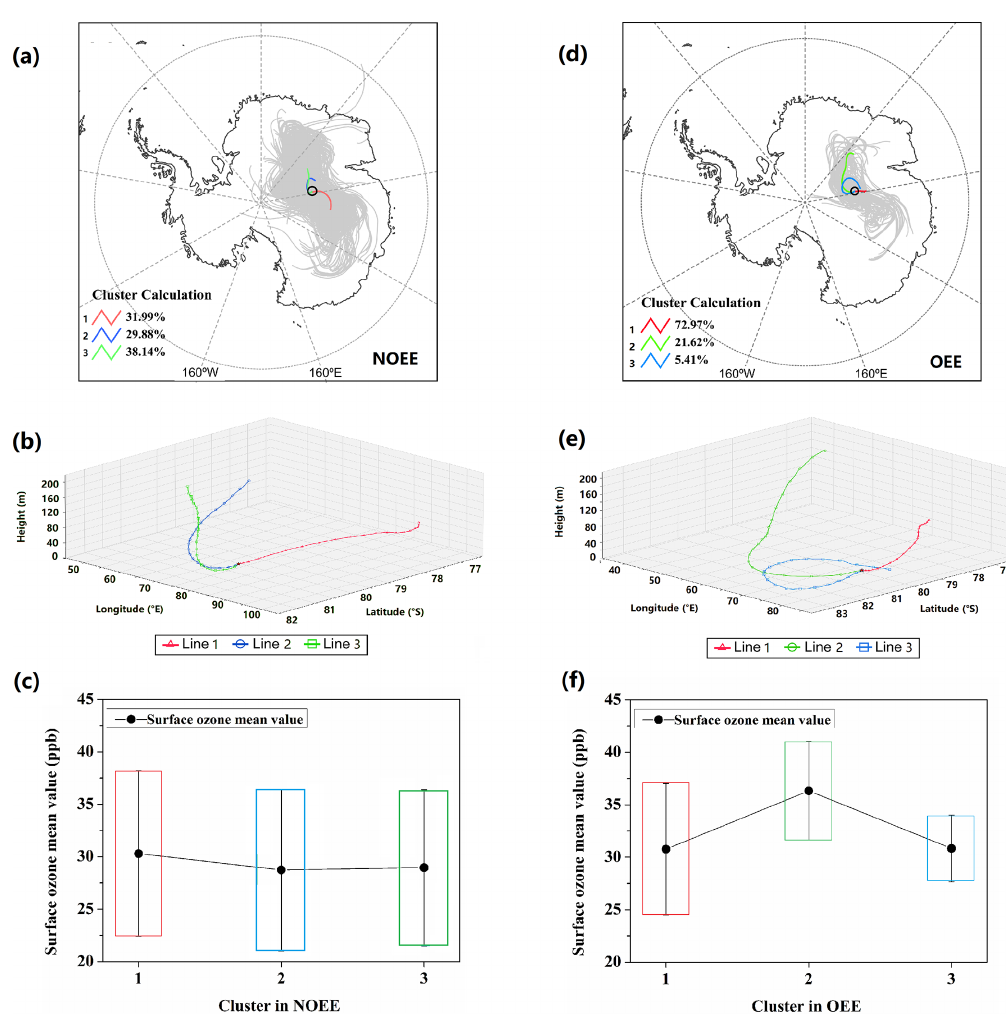
Figure 8. Backward HYSPLIT trajectories for each measurement day (gray lines in panel a ) and mean back trajectory for three HYSPLIT clusters (colored lines in panel a ; 3-D view shown in panel b ) arriving at Kunlun Station during NOEEs. Panel (c) shows the range of surface ozone concentrations measured at DA by cluster. The error bar is the standard deviation of the same cluster. Panels (d) – (f) are the same as panels (a) – (c) but for